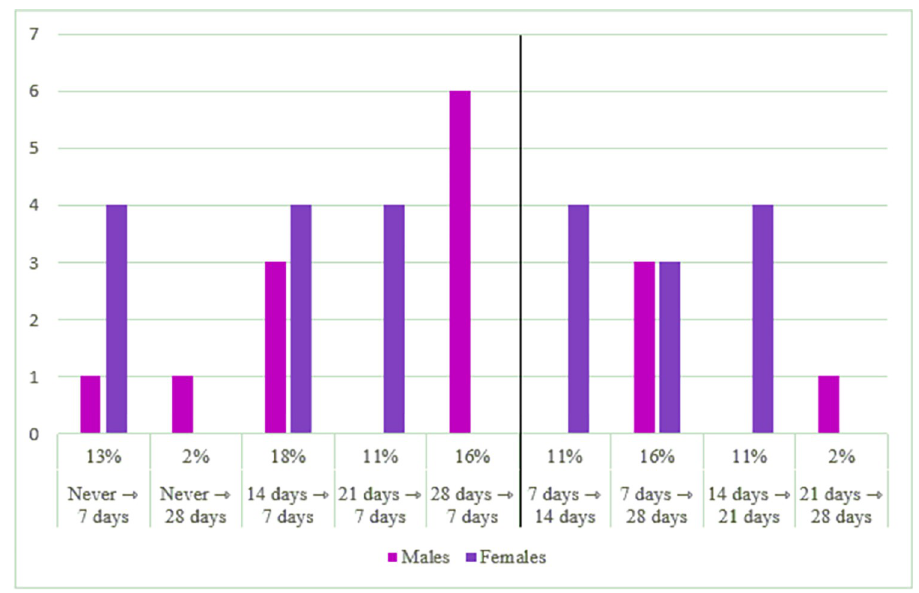
Fig 2. Preference changes for radiology and pathology test results.